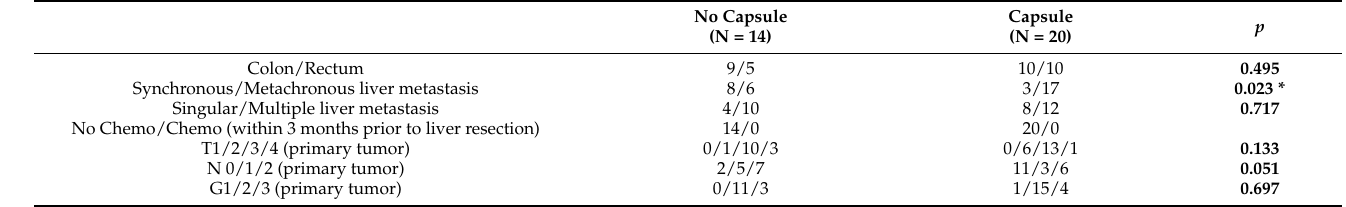
Table 3. Demographics of selected patients with colorectal liver metastases with and without